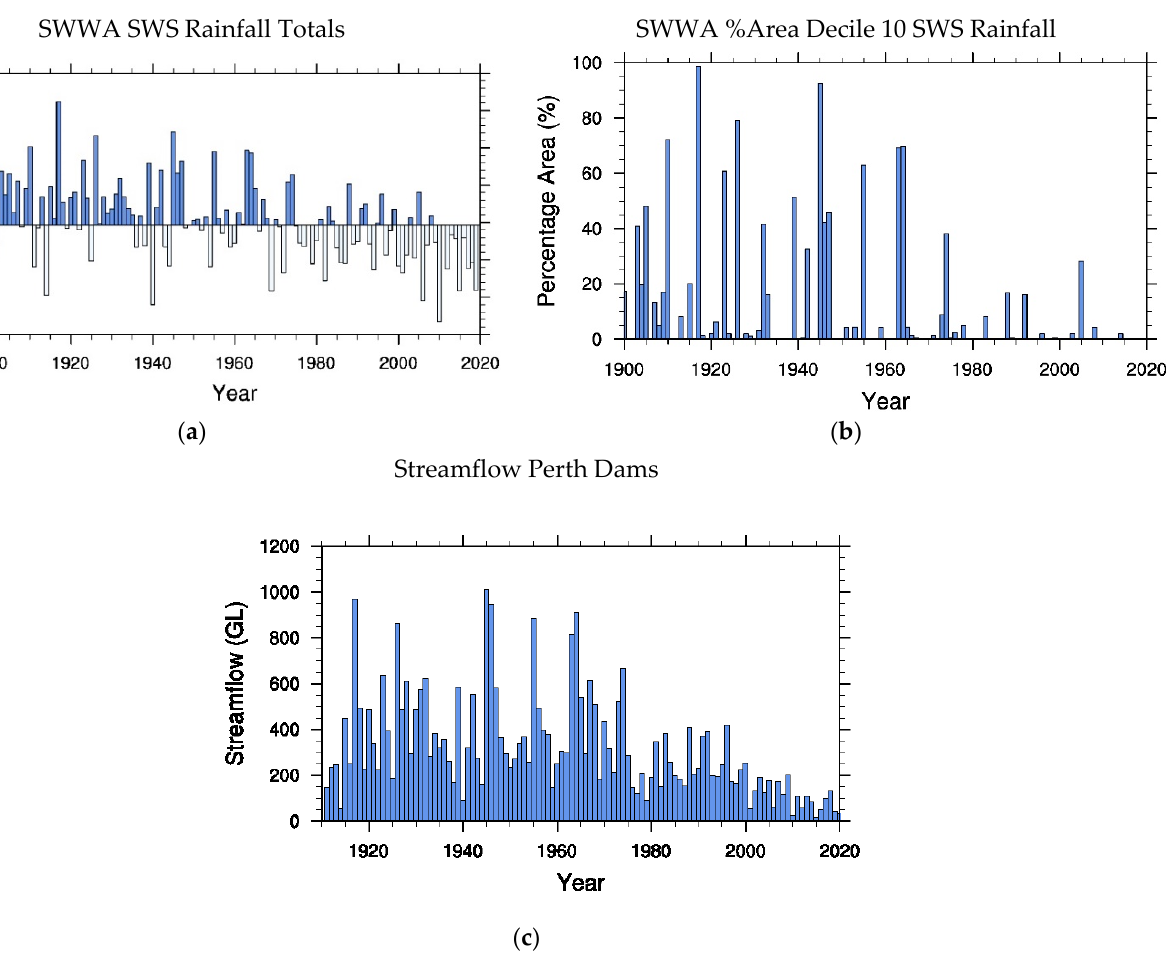
Figure 2. Interannual variability of ( a ) 1900–2019 SWWA rainfall totals (mm) for April–November (SWS), ( b ) 1900–2019 percentage area (%) of SWWA with rainfall in decile 10 (PAR D10 ) for SWS and ( c ) 1911–2018 January–December streamflow (GL) into Perth dams.